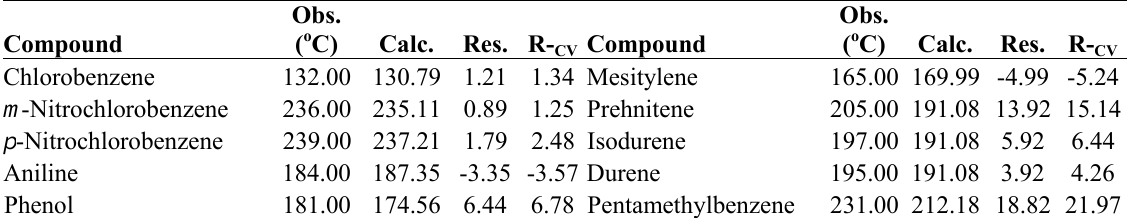
Table 14 . Experimental and Calculated Values of the Bp of Molecules Included in the Training Set, that Contain Aromatic Cycles in Their Molecular Structure, as Well as Residual of Regression and